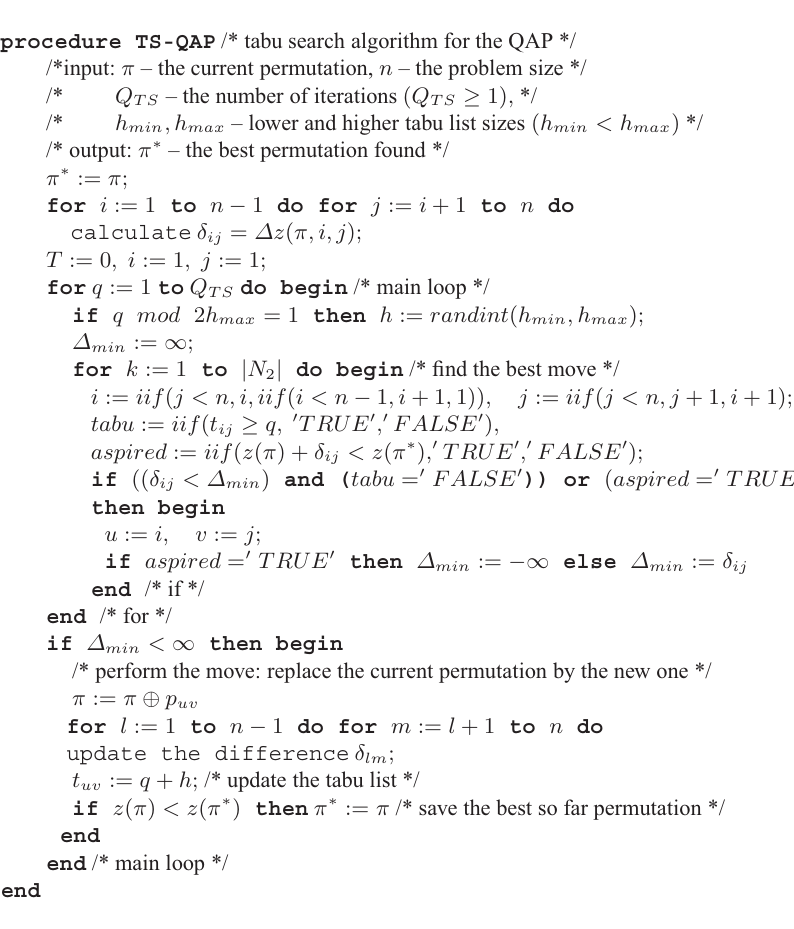
Figure 9. Pseudo-code of the tabu search algorithm for the QAP, here ∆z ( π,i, j ) is calculated according to the formula (1.3), while the difference δ lm is updated according to (1.4). The function " randint ( x, y ) " returns a random integer, uniformly distributed between x and